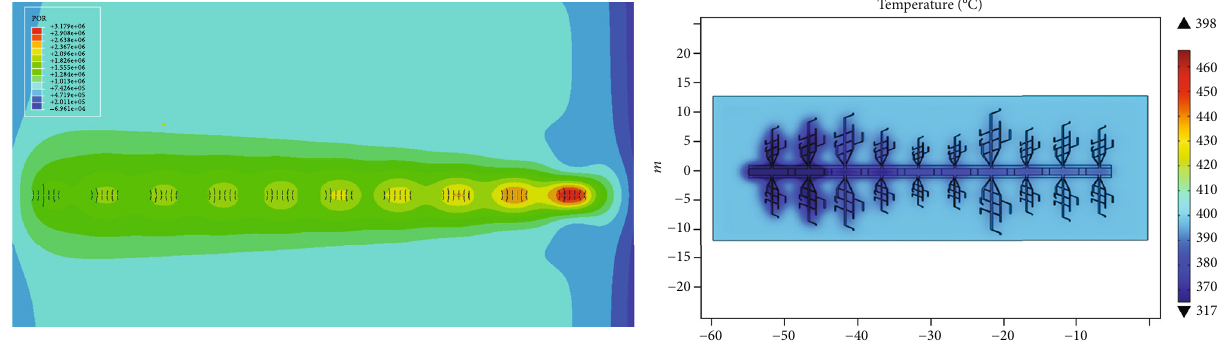
Figure 13: Stress distribution around the fracture in the soaking period and temperature distribution after shut-in (24 h) [127].